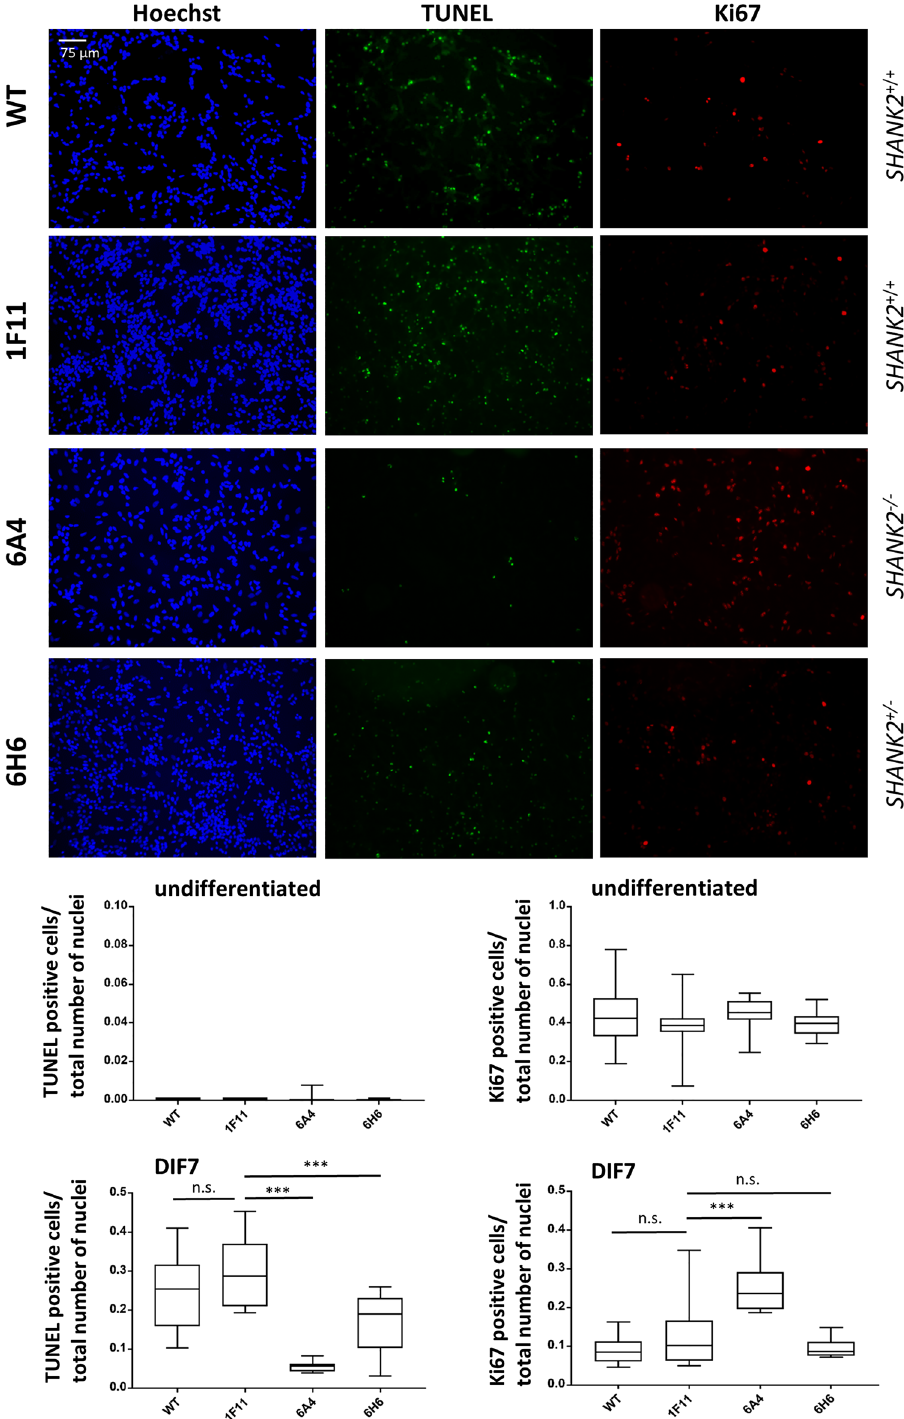
Figure 2. Analysis of apoptosis and cell proliferation in SHANK2 mutant cell lines. A TUNEL assay was carried out to determine the rate of apoptotic cells and TUNEL-positive cells were quantified relative to the total number of nuclei (Hoechst), revealing significantly lower numbers of TUNEL-positive cells for both SHANK2 mutant lines compared to the control 1F11 (one-way ANOVA, F = 22.74, P < 0.0001, P-values after correction for multiple testing with Dunnett’s test 6A4 P < 0.0001, 6H6 P = 0.0004, WT P = 0.326) after 7 days of differentiation (DIF7). In addition, immunofluorescence microscopy was carried out with the proliferation marker Ki67 followed by quantification of the Ki67 positive cells versus the total number of nuclei. A significantly increased number of Ki67-positive cells was identified in cell line 6A4 with bi-allelic SHANK2 mutation in comparison to the control 1F11 (one-way ANOVA, F = 20.97, P < 0.0001, P-values after correction for multiple testing with Dunnett´s test 6A4 P < 0.0001, 6H6 P = 0.49, WT P = 0.327) at DIF7. The pictures illustrate the expression after 7 days of differentiation. No difference was observed between the two control lines WT and 1F11. Undifferentiated cell lines showed equally low apoptosis levels (one-way ANOVA, F = 2.285, P = 0.09, corrected P-values